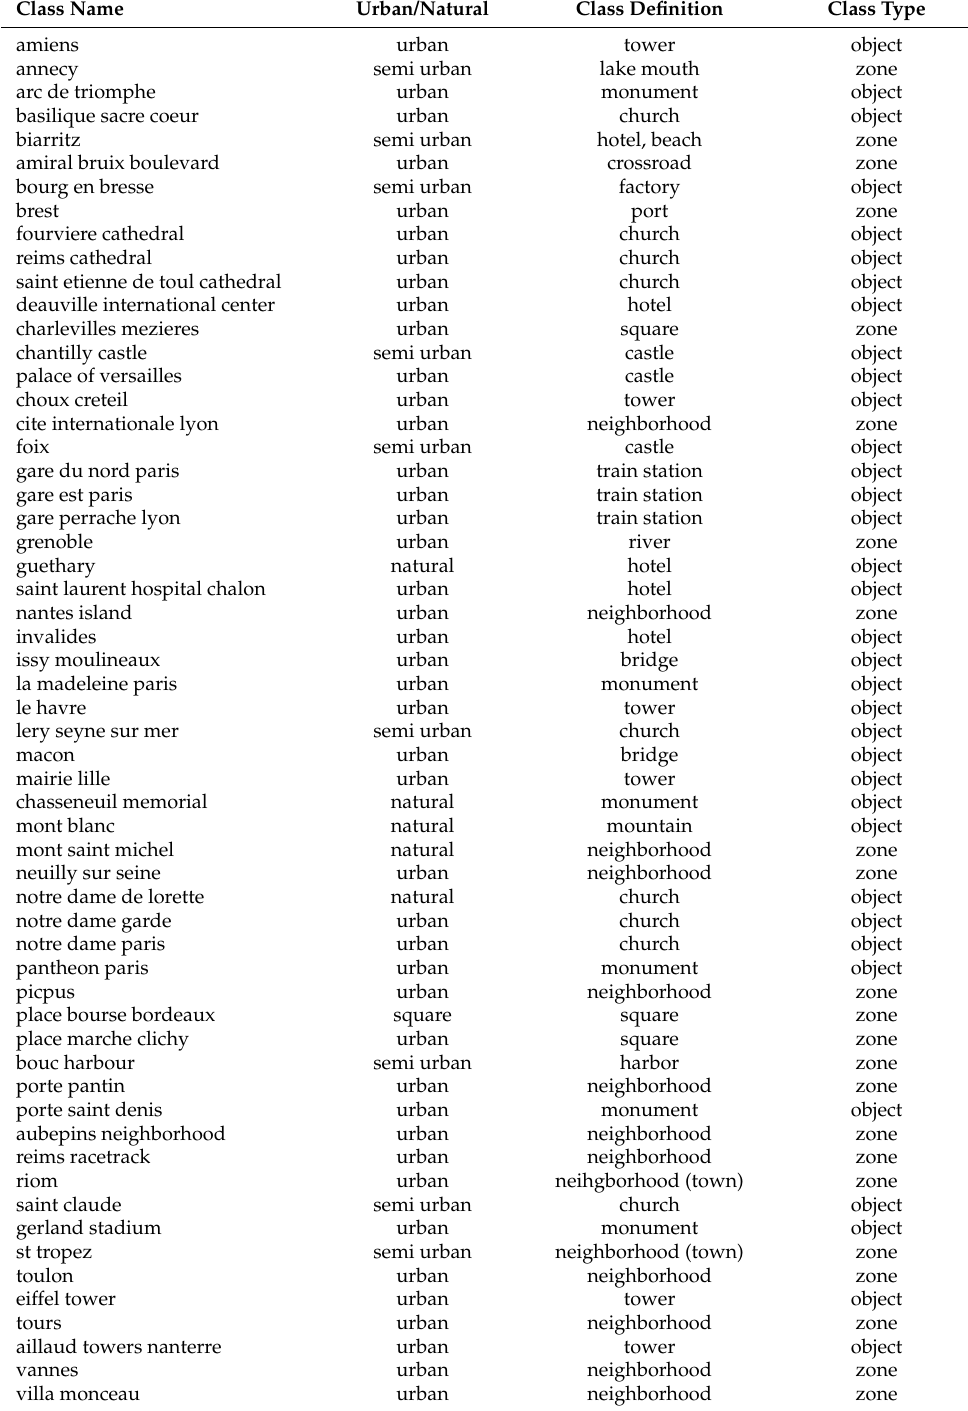
Table A1. Details of the classes in the ALEGORIA